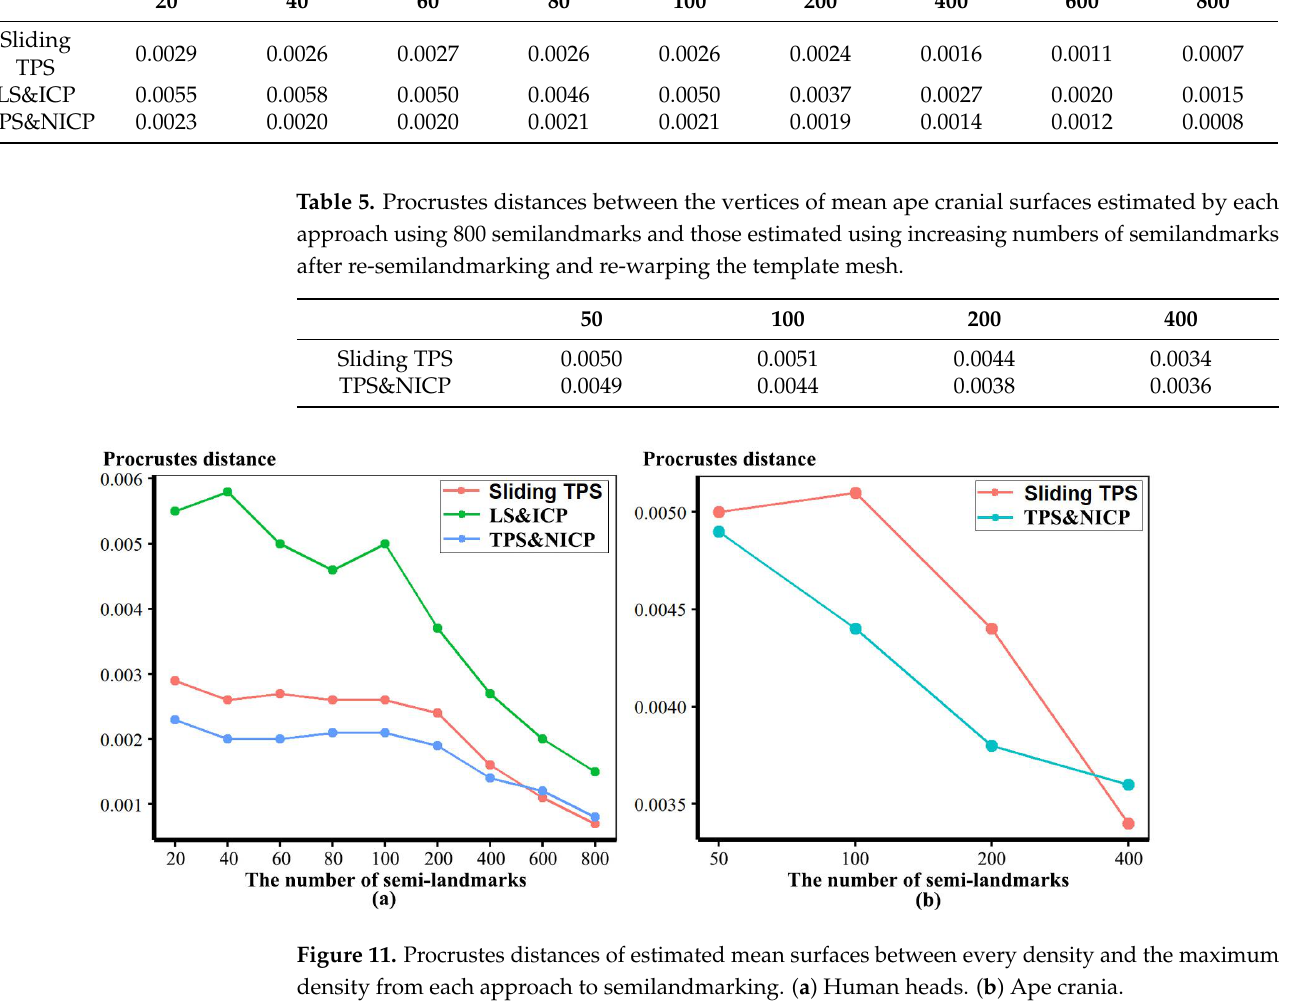
Table 4. Procrustes distances between the vertices of the estimated mean human head surfaces using 1000 semilandmarks and those using increasing numbers of semilandmarks from each approach after re-semilandmarking and re-warping the template mesh.